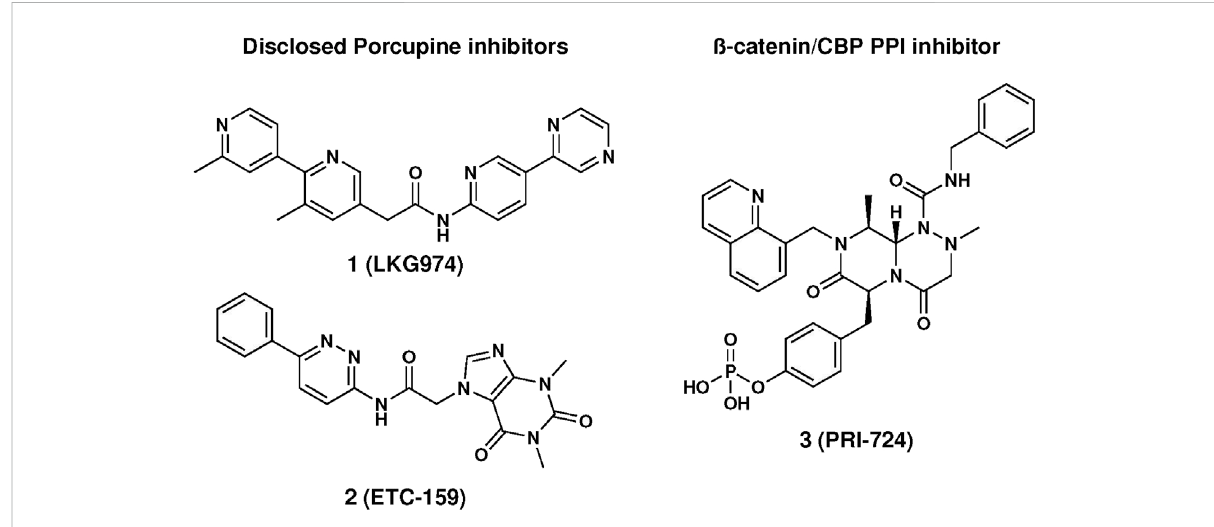
FIGURE 1 Structure of disclosed